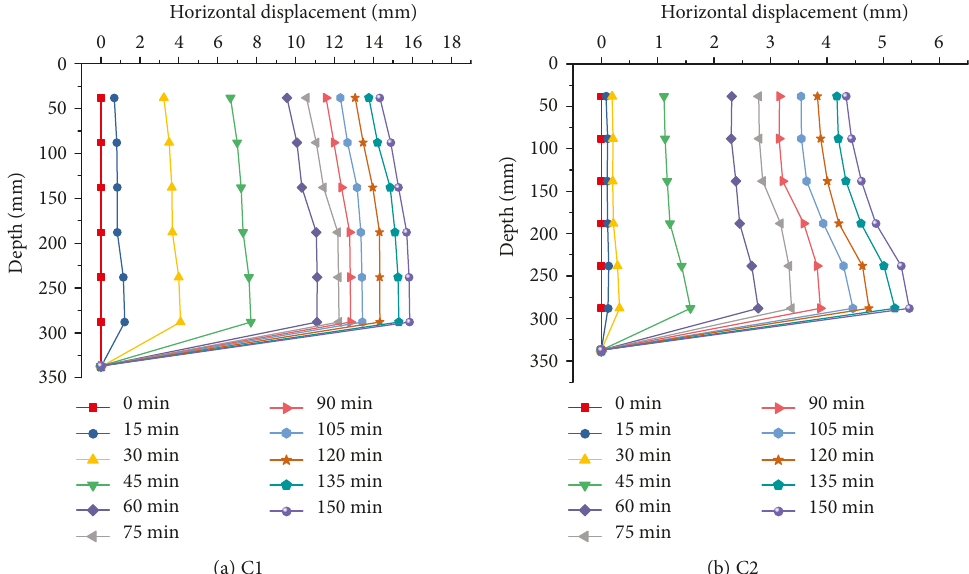
Figure 9: Variation of the deep displacement in fl exible inclinometer probes of (a) C1 and (b) C2.